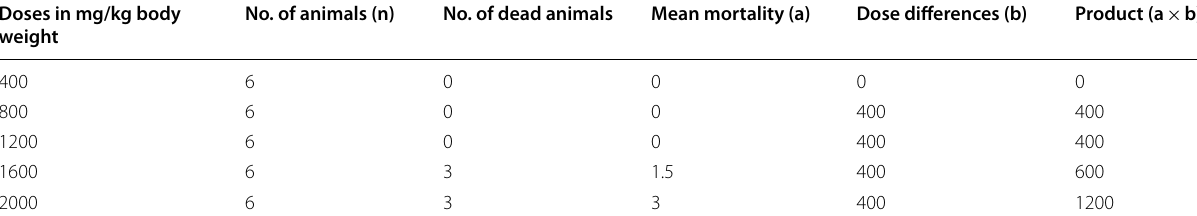
Table 8 Determination of LD50 of E. indicum (methanol extract) Doses in mg/kg body weight